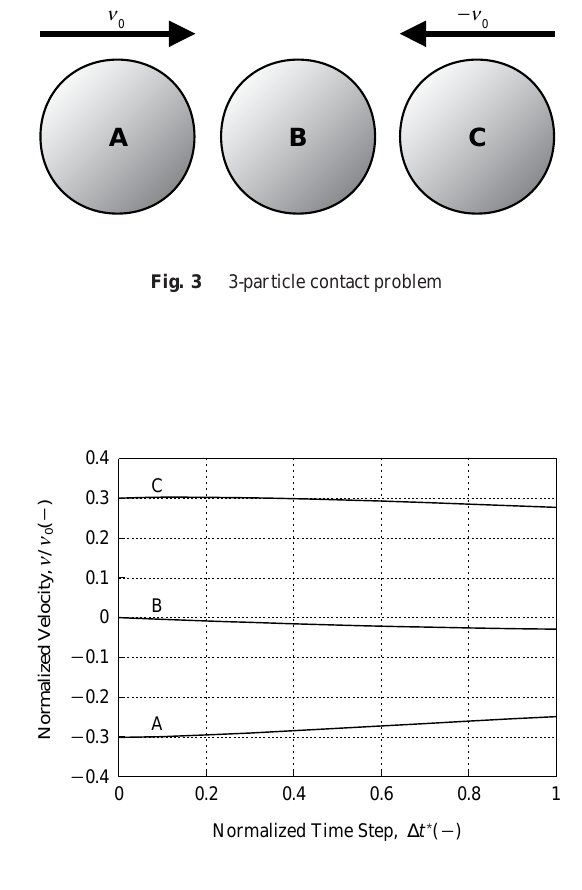
Fig. 4 Normalized velocity of the 3-particle problem